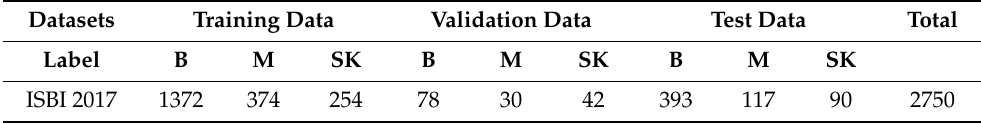
Table 2. Distribution of ISBI 2017 dataset.